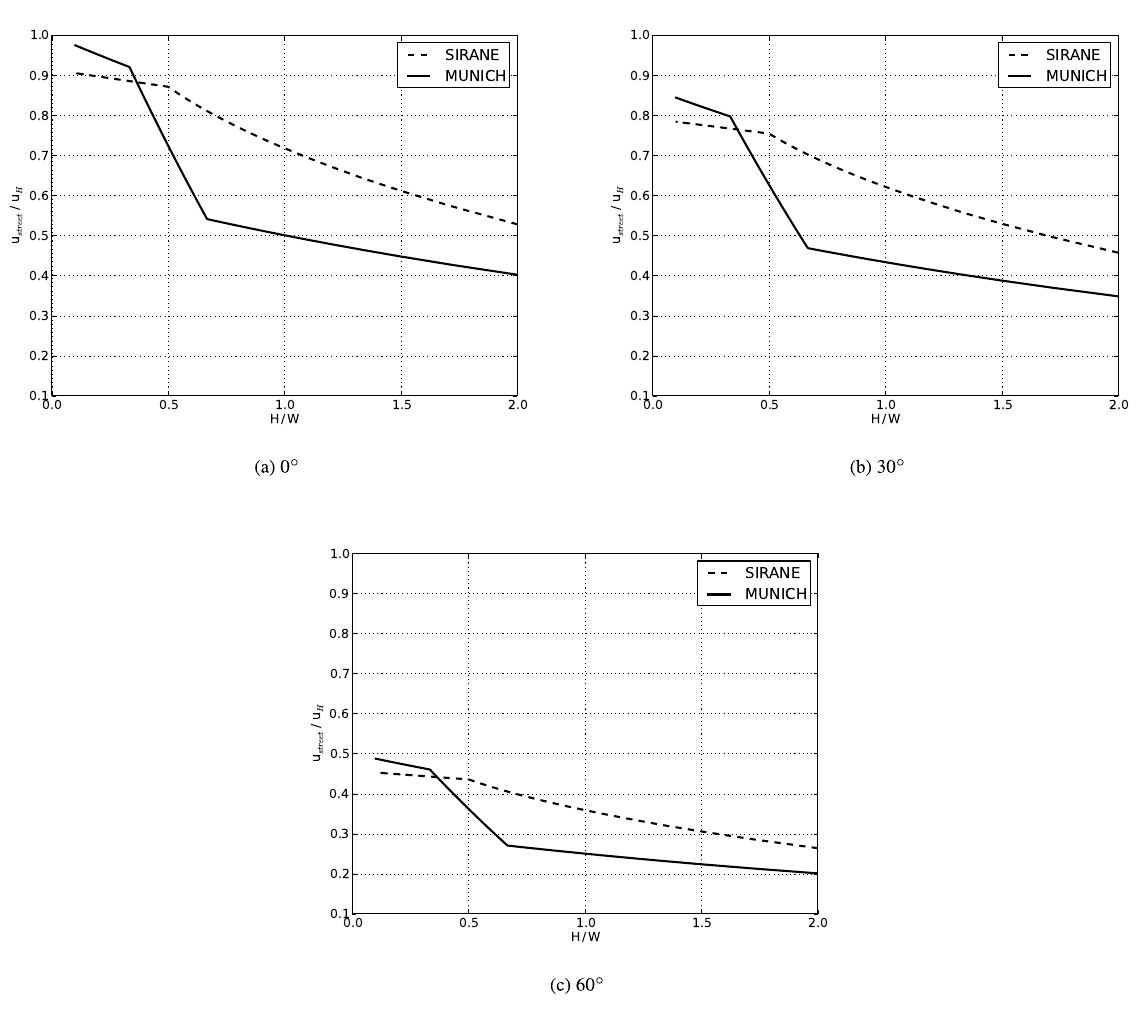
Figure 2. Comparison of the mean horizontal wind velocity (normalized with respect to the wind speed at roof level) within the street canyon calculated with the profiles of SIRANE (Soulhac et al., 2008) (dotted lines) and MUNICH (Lemonsu et al., 2004) (solid lines) as a function of the street aspect ratio for three different angles between the wind direction and the street direction: (a) 0 ◦ , (b) 30 ◦ , and (c) 60 ◦